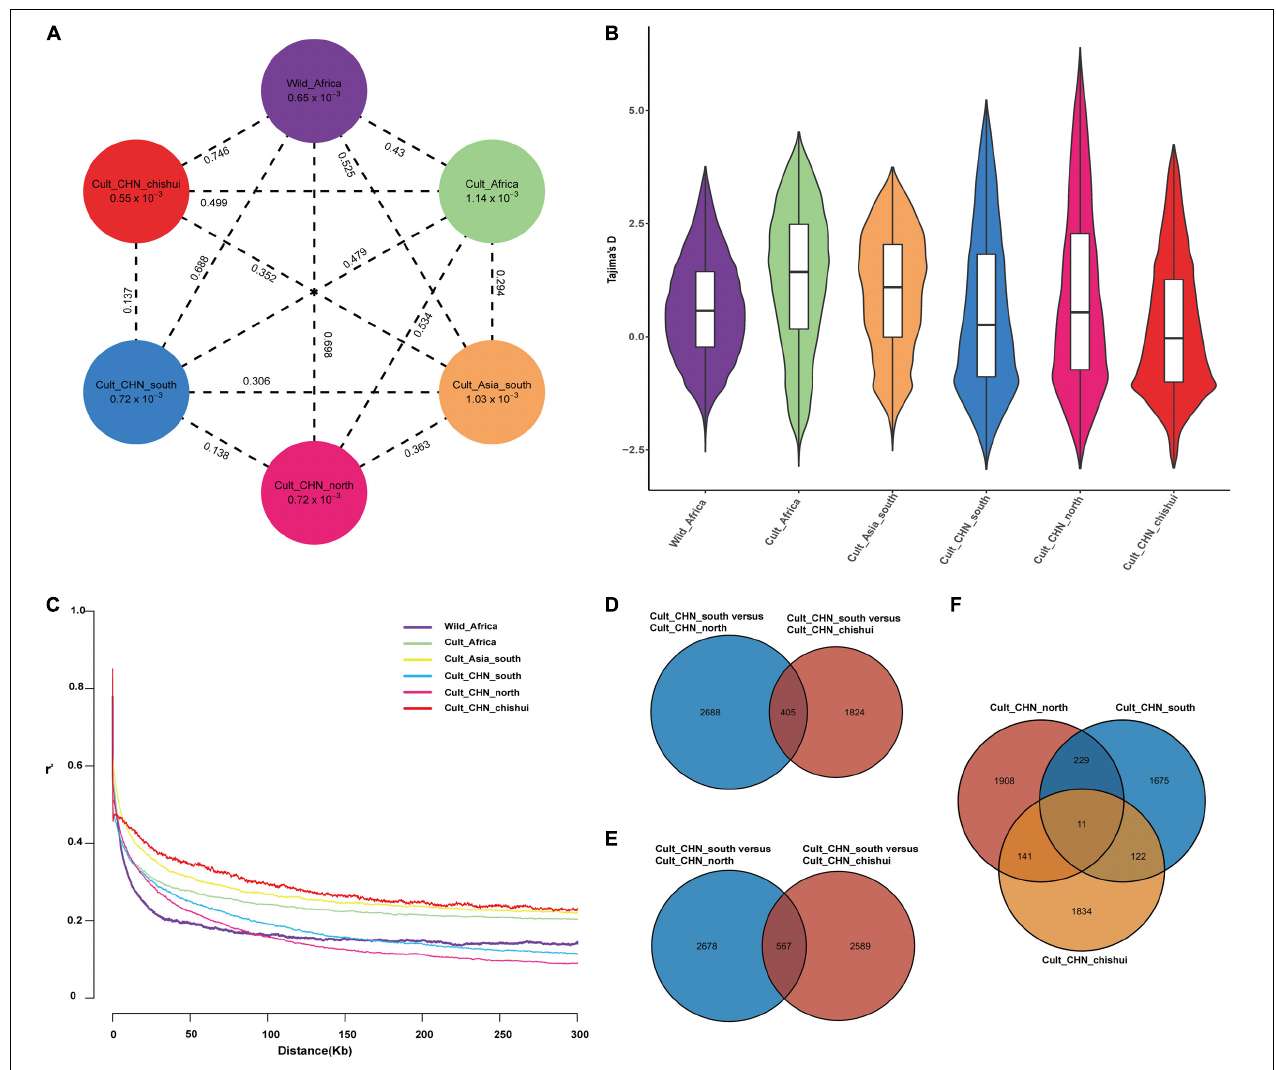
FIGURE 2 | Evolution history of Chinese sorghum. (A) Nucleotide diversity ( π ) and population divergence ( Fst ) across the six populations. The values in the circle represent the mean value of π for each group; the values on each dotted line indicate pairwise Fst between populations. (B) Violin plots showing Tajima’s D estimation in six sorghum populations. (C) LD decay in different sorghum populations. (D–F) Venn diagrams representing the number of unique and shared domestication genes among Chinese sorghum populations, based on the selected thresholds top 5% of Fst , π ratio values, and Tajima’s D negative values